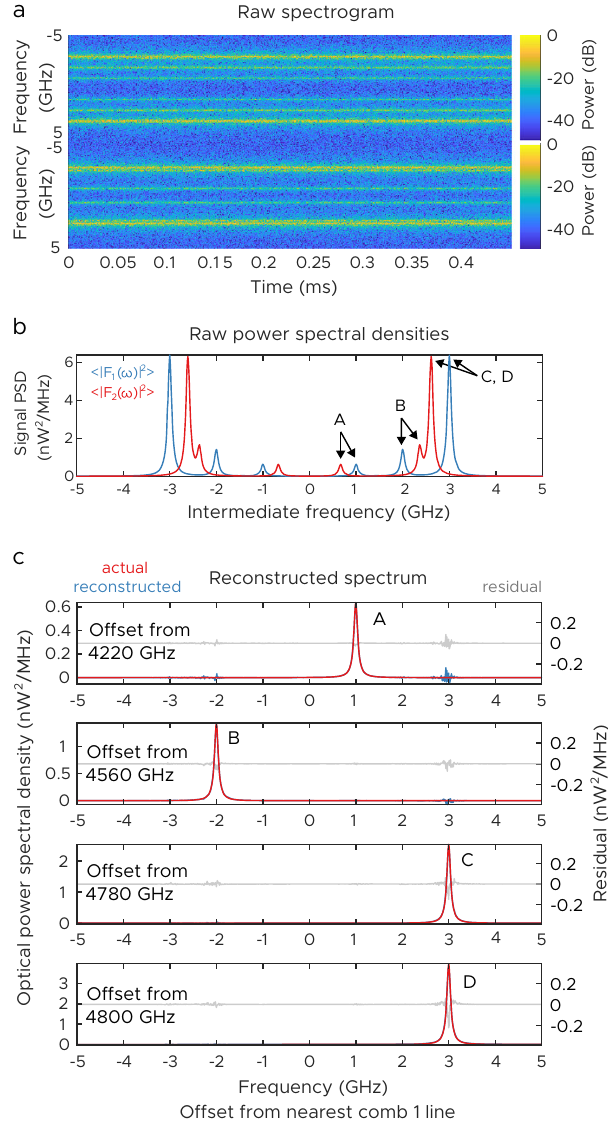
Fig. 3 Simulated narrowband terahertz ptychoscopic experiment. a Magnitudes of the recorded spectrograms as a function of slow time and IF frequency (10 MHz RBW, 0.45 ms measurement time). b Raw signal power spectral densities, with contributions from beating with various lines labeled. c Reconstructed signals calculated from Eq. (2), along with the actual